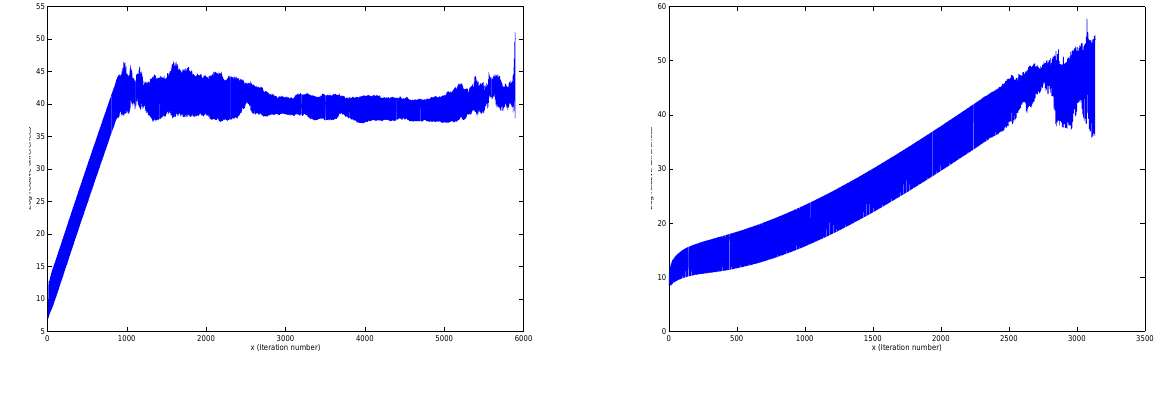
Figure 4. (Left) Example of simultaneous normalization, (Right) Same example zoomed